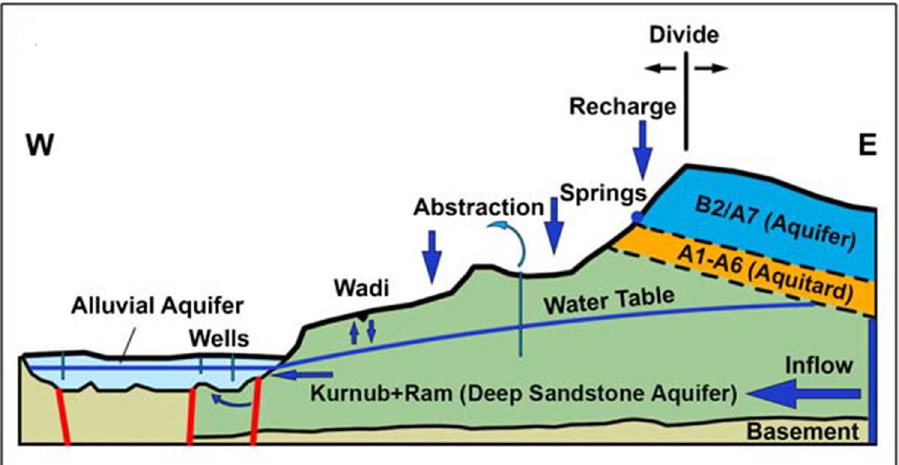
Fig. 3 Hydrogeological cross section of the Wadi Araba Basin (Radulovic et al.